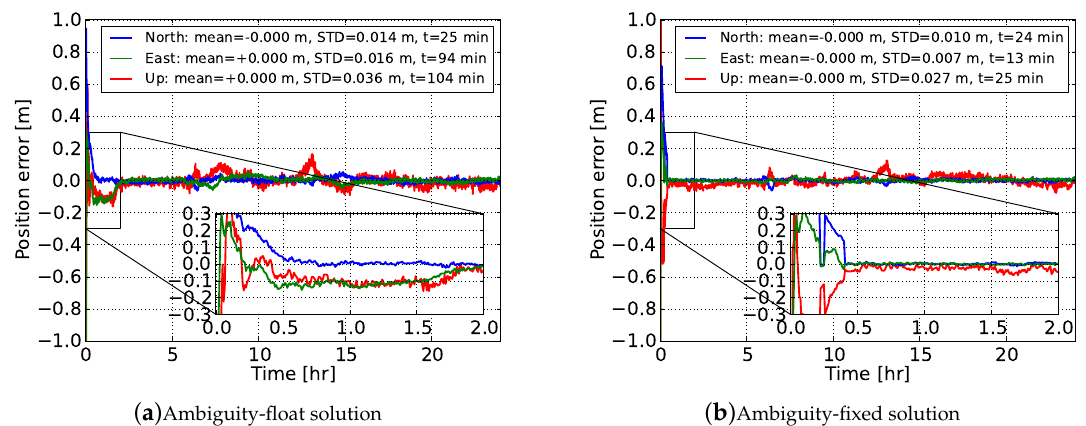
Figure 6. Time-series of the GPS dual-frequency ionosphere-float ( a ) PPP and ( b ) Full integer ambiguity resolution (FAR)-based PPP-RTK kinematic user position for station NCWL with respect to its ground-truth. The empirical means and STDs are calculated for the estimated positions after 2 h. A zoom-in window during the first 2 h is